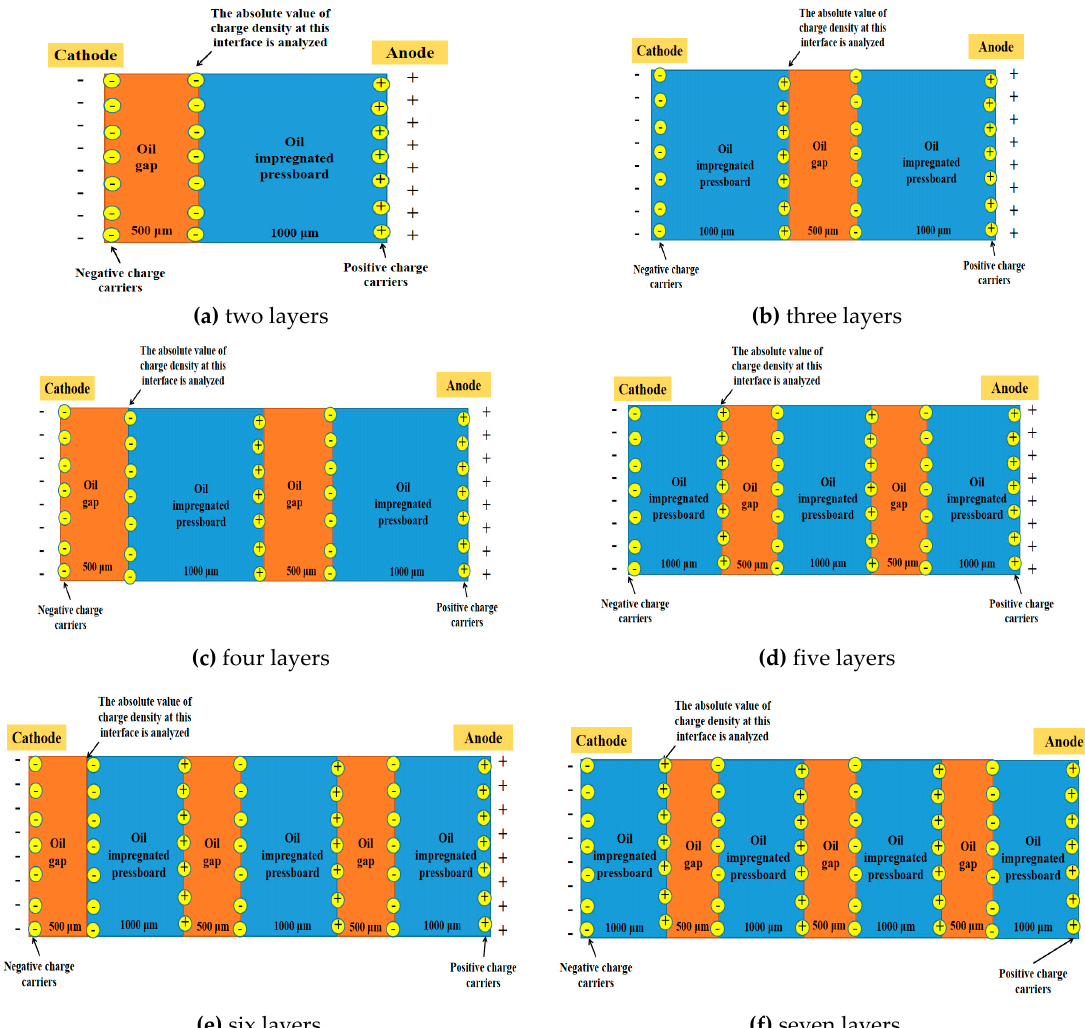
Figure 5. The oil-paper insulation structures with different layers.